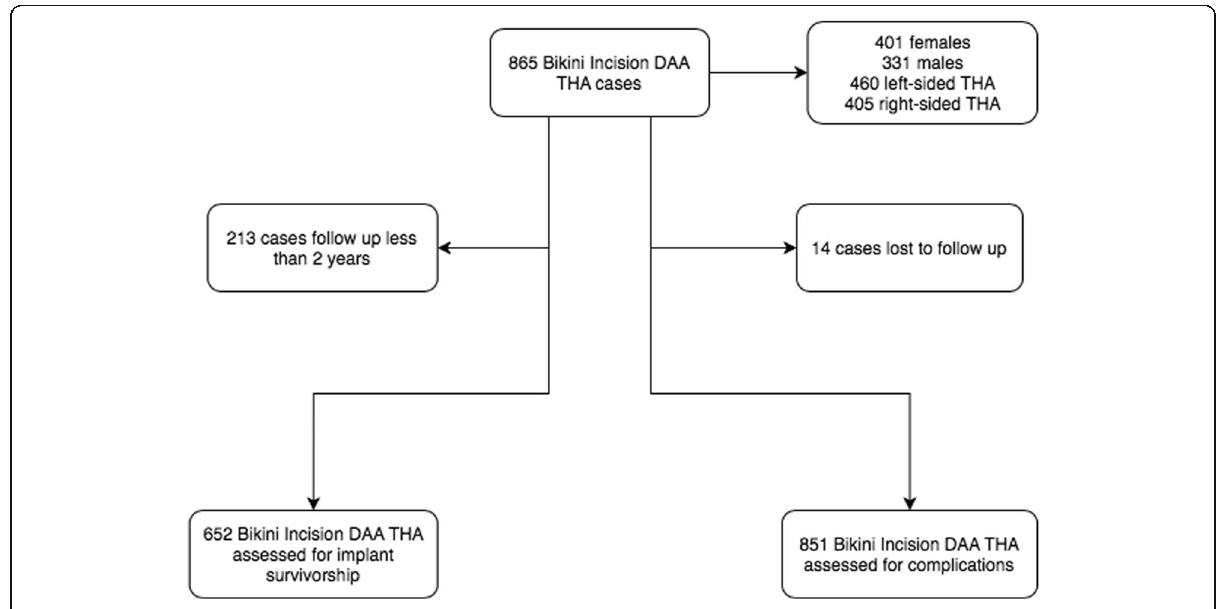
Fig. 1 Flow chart with overview of